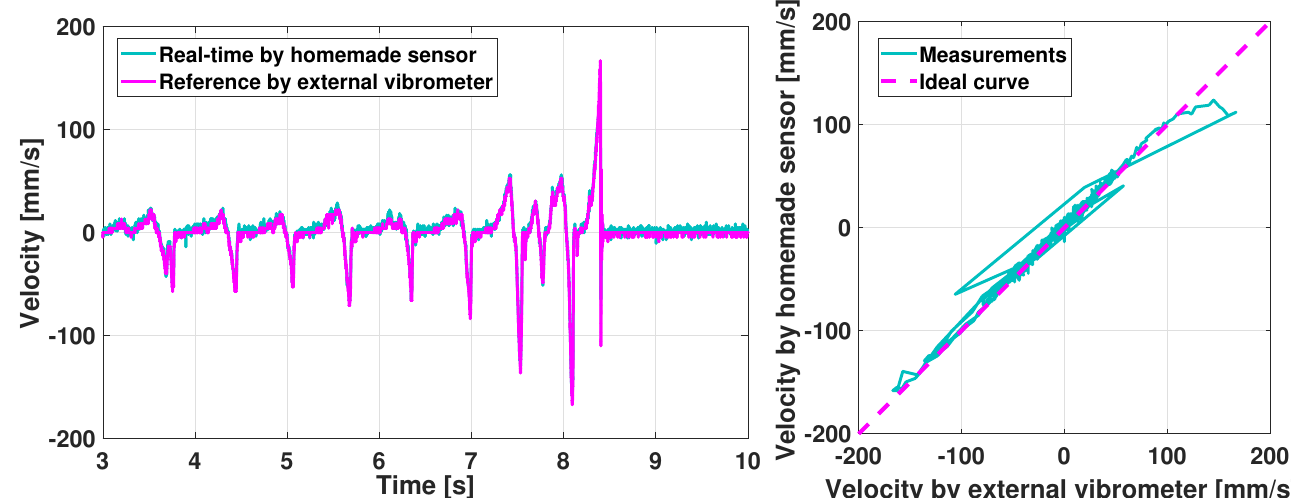
Figure 22. Haptic key validation of the velocity sensor: halfway keystroke.